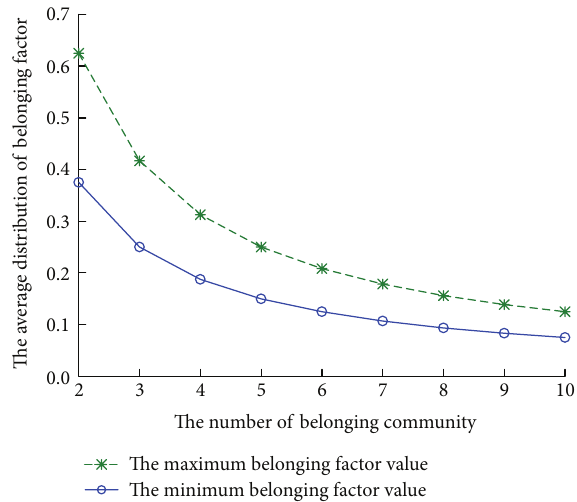
Figure 4: The graph of maximum and minimum value in average distribution.